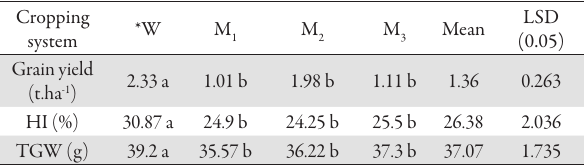
Tab. 7. Effect of different cropping system on wheat grain